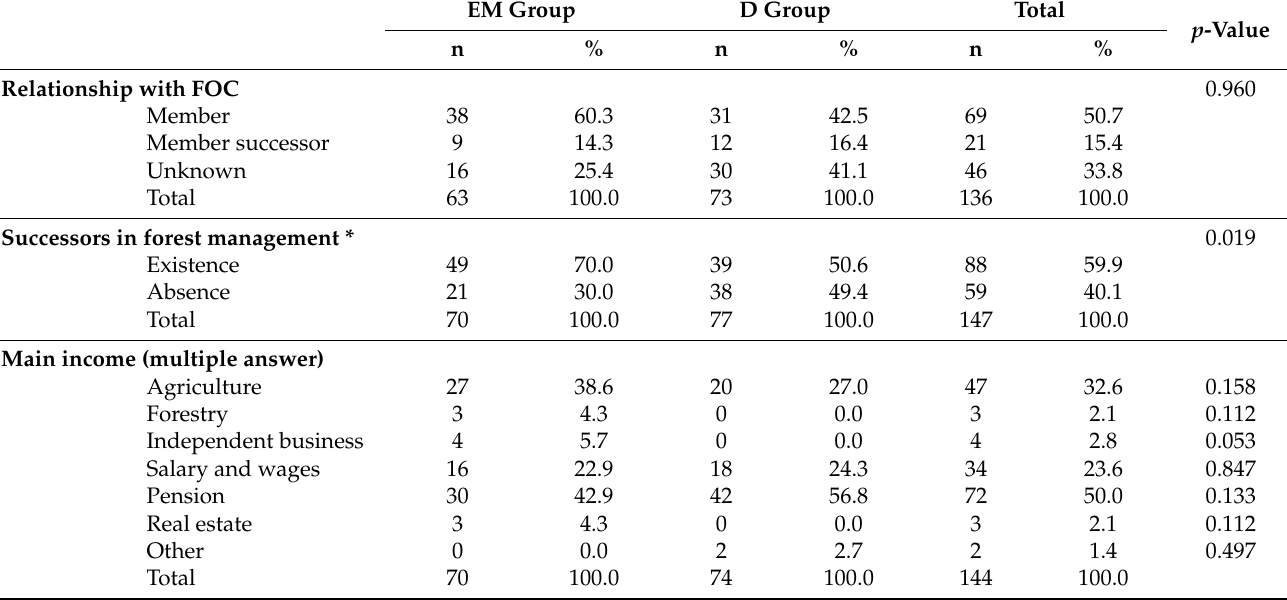
Table 5. Comparison of PFOs’ characteristics between the two groups in Kunitomi.